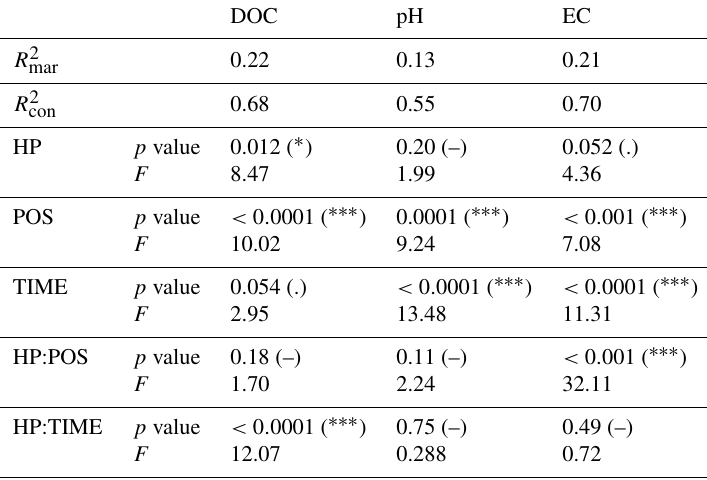
Table 1. Summary of statistics from the LMM models for DOC, pH, and EC. The three columns show the response variables DOC, pH, and EC. The upper two rows show the marginal and conditional coefficients of determination ( R 2 mar and R 2 con ), which explain the vari- ance due to the fixed effects as well as the variance due to the fixed and random effects combined. For each explanatory variable and the interaction with hydrological pathways (HP), the p value and F statistic are presented. HP differentiates between DRIPs and non-DRIPs. POS represents the three positions in the along-transect areas: riparian, transition, and upland. TIME represents the three different sea- sons in which sampling took place: spring, summer, and fall. Significance is defined as follows: p < 0 . 001 “ ∗∗∗ ”, 0 . 001 < p < 0 . 01 “ ∗∗ ”, 0 . 01 < p < 0 . 05 “ ∗ ”, 0 . 05 < p < 0 . 1 “.”, and p > 0 . 1 “–”. Explanatory variables displayed as “variable1:variable2” represent the interaction between both variables. DOC pH EC R 2